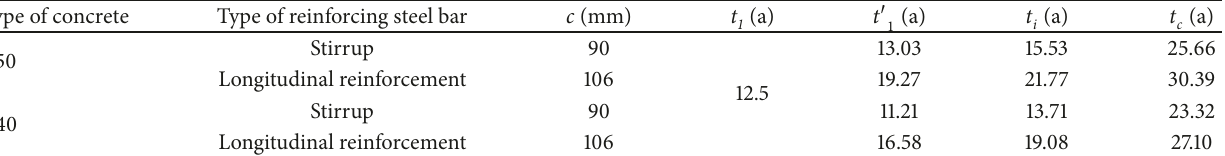
Table 4: Initial time of steel-bar